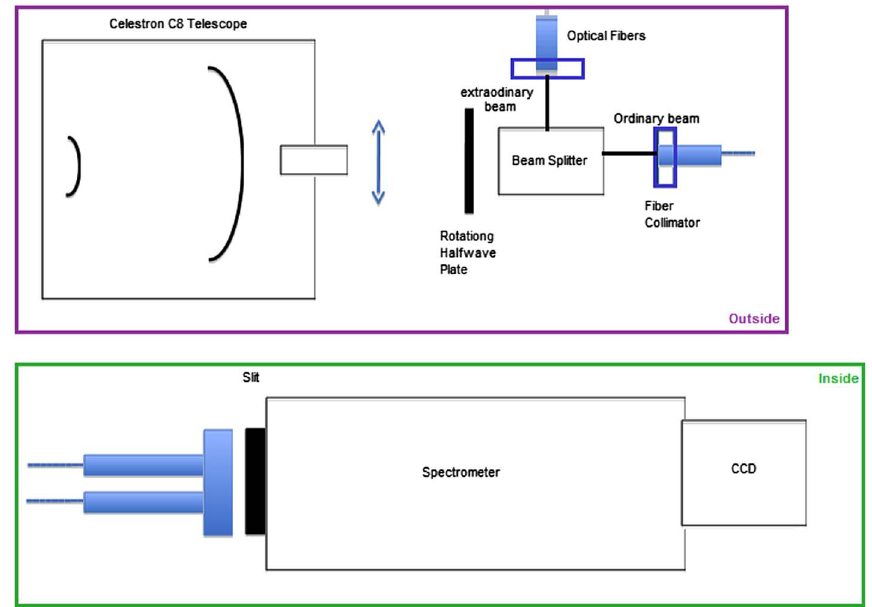
Fig. 1. Concept of the Premier Cru instrument. The purple part is in a box located outside while the green one is inside the adjacent observatory. A 50 m long and 600 l m diameter double core optical fi ber links the two